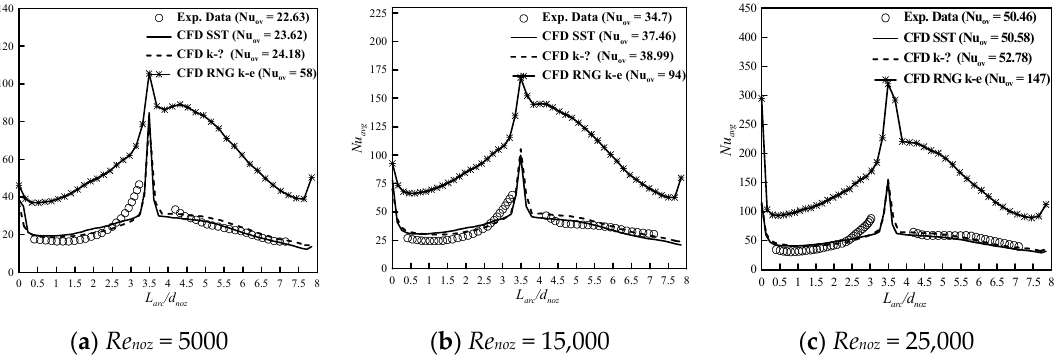
Figure 4. Nusselt number contours for both experimental (without mainstream [39]) and numerical results of impingement cooling at ( a ) Re noz = 5000, ( b ) Re noz = 15,000 and ( c ) Re noz = 25,000.